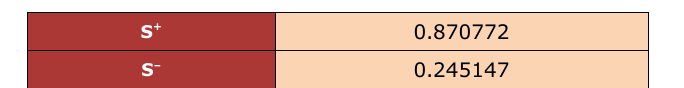
Table 6. Degree of similarity of alternatives (France as a sample) and PIS and NIS